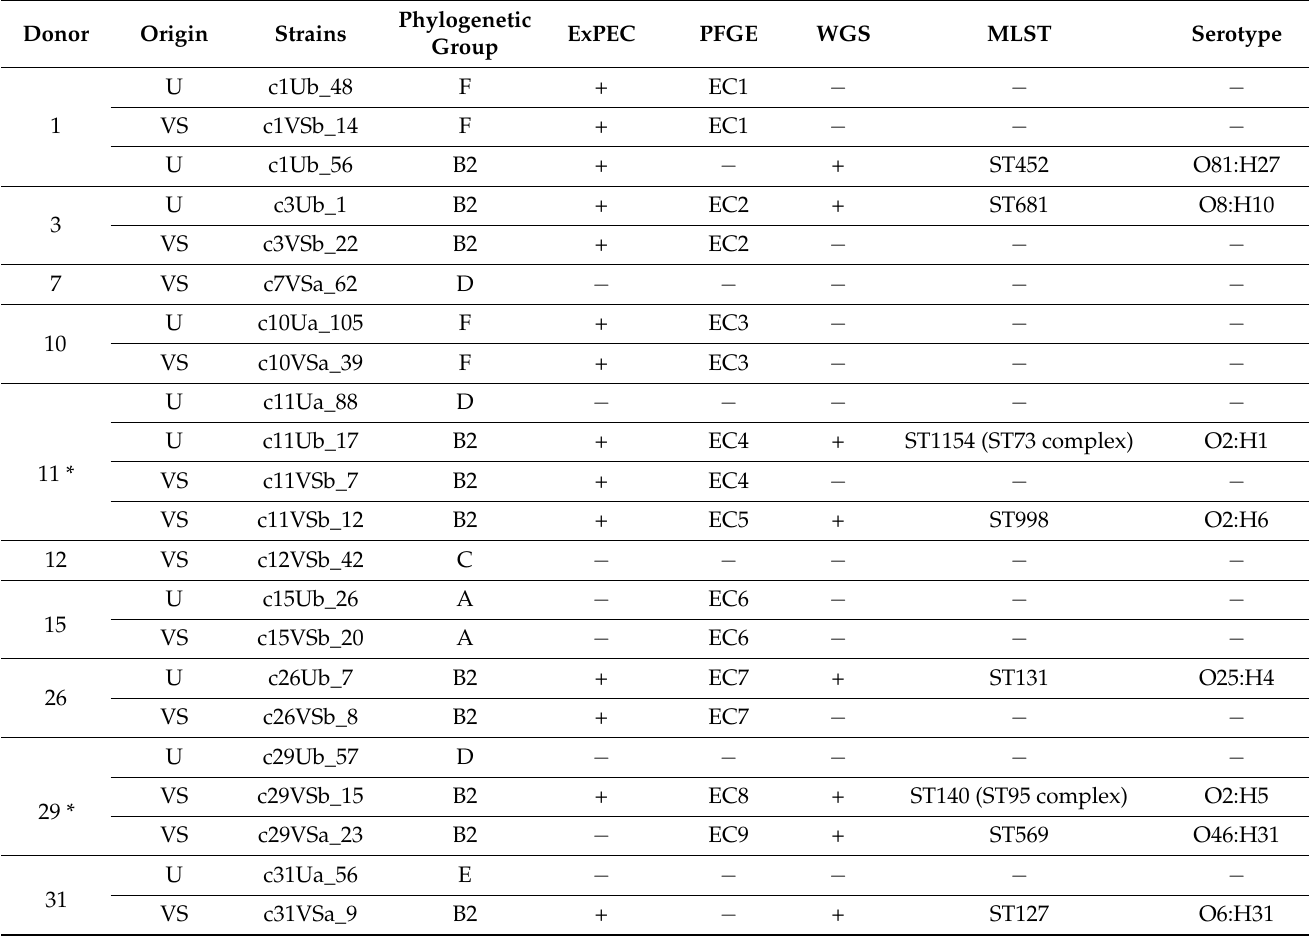
Table 1. Phylogenetic origin and diversity of urinary ( n = 10) and vaginal ( n = 12) E. coli strains isolated from healthy